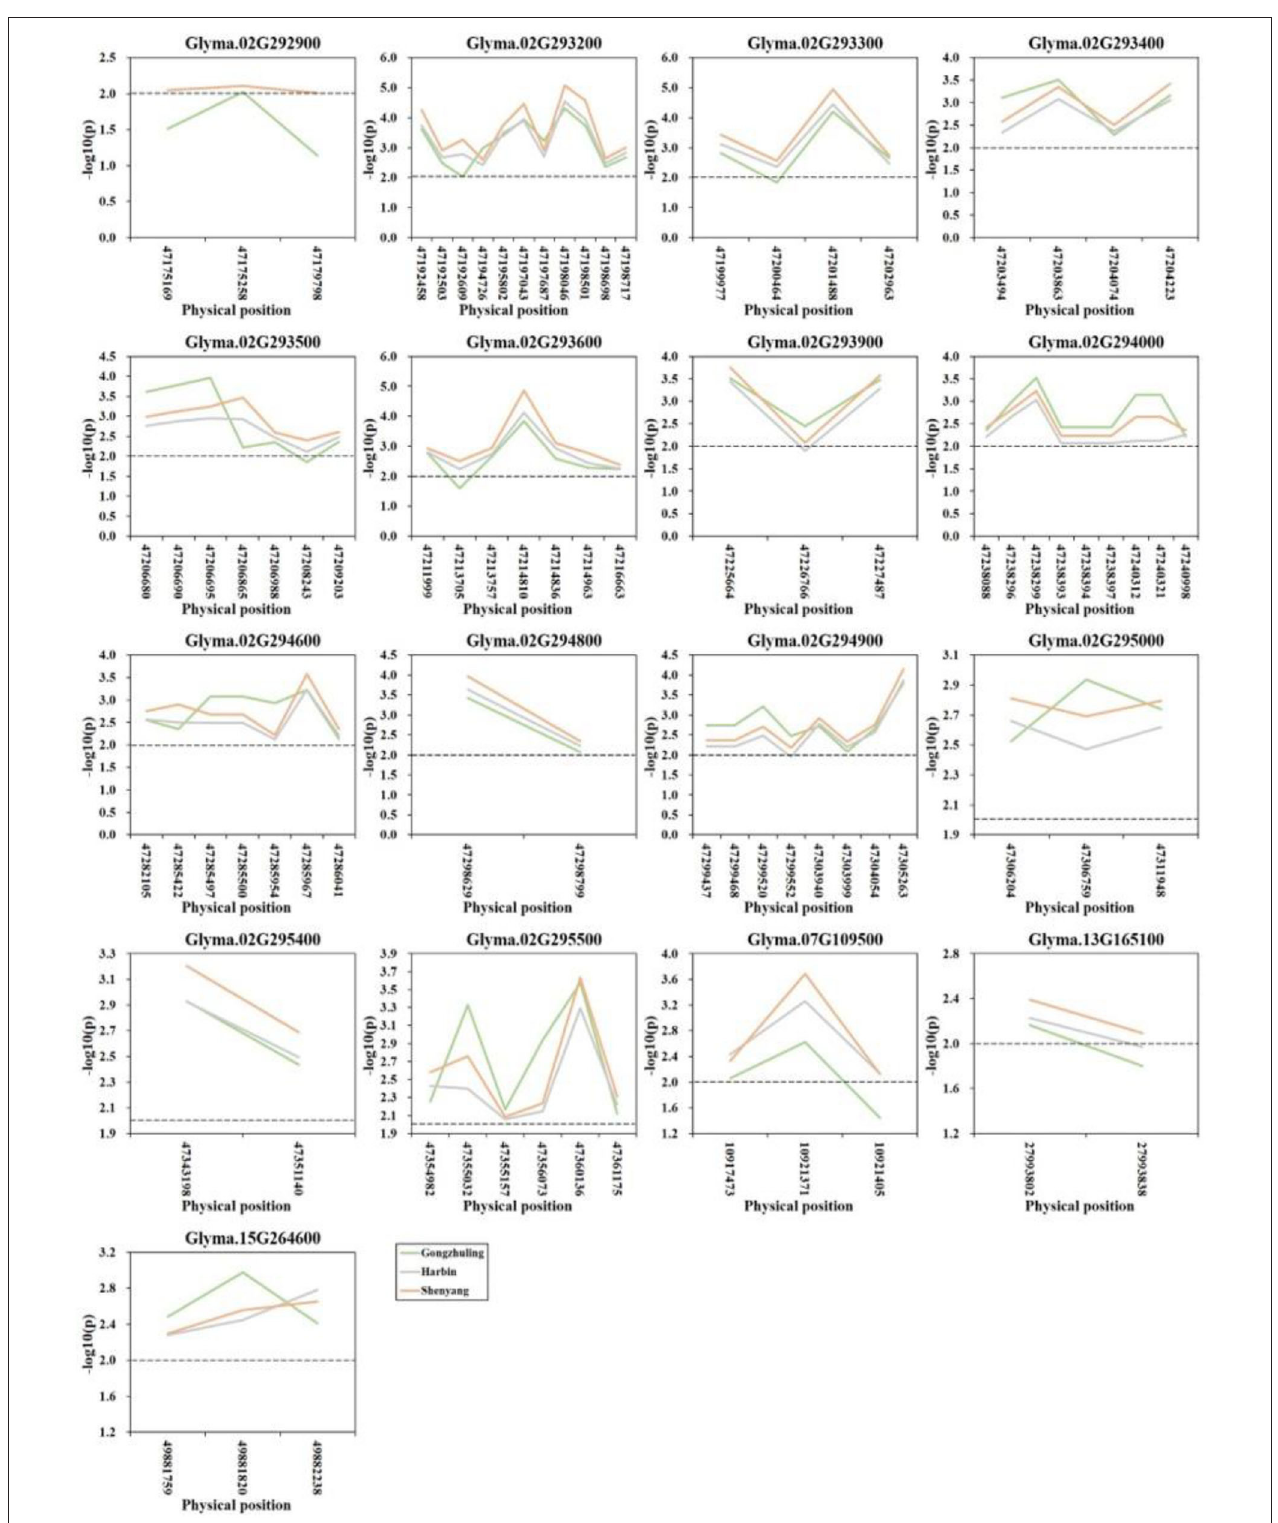
FIGURE 5 | Candidate gene-based association analysis with total soluble sugar content. Horizontal line indicates that the threshold is set to 2.0.